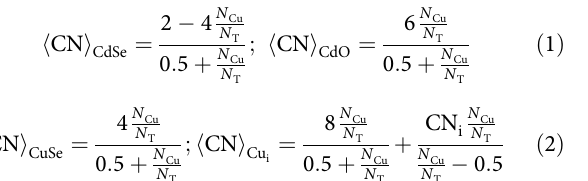
Fig. 5 Comparison of the experimental and theoretical changes in coordination number with copper concentration. Coordination number, CN, versus the number of copper atoms (N Cu ) normalized to the number of atoms (N T ) in the nanocrystal. ( a ) Experimental data (CN extracted via fi ts of the EXAFS data) for three different particles sizes and two different metal K-edges (error bars have been removed for clarity; for an idea of the general error associated with the data points, see the error bars in Fig. 4a and c) and ( b ) Theoretically predicted change in CN with concentration. Details on the theoretical calculations are provided in the main The experimental data can be simply explained by considering the changes in the average coordination numbers as increased amounts of copper are introduced during the stages of the CE reaction. For comparison, we have calculated and plotted (Fig. 5b) the expected change in coordination number, CN, as a function of Cu concentration ( N Cu ) based upon the following N T relationships (the justi fi cation for these equations can be found in Methods),